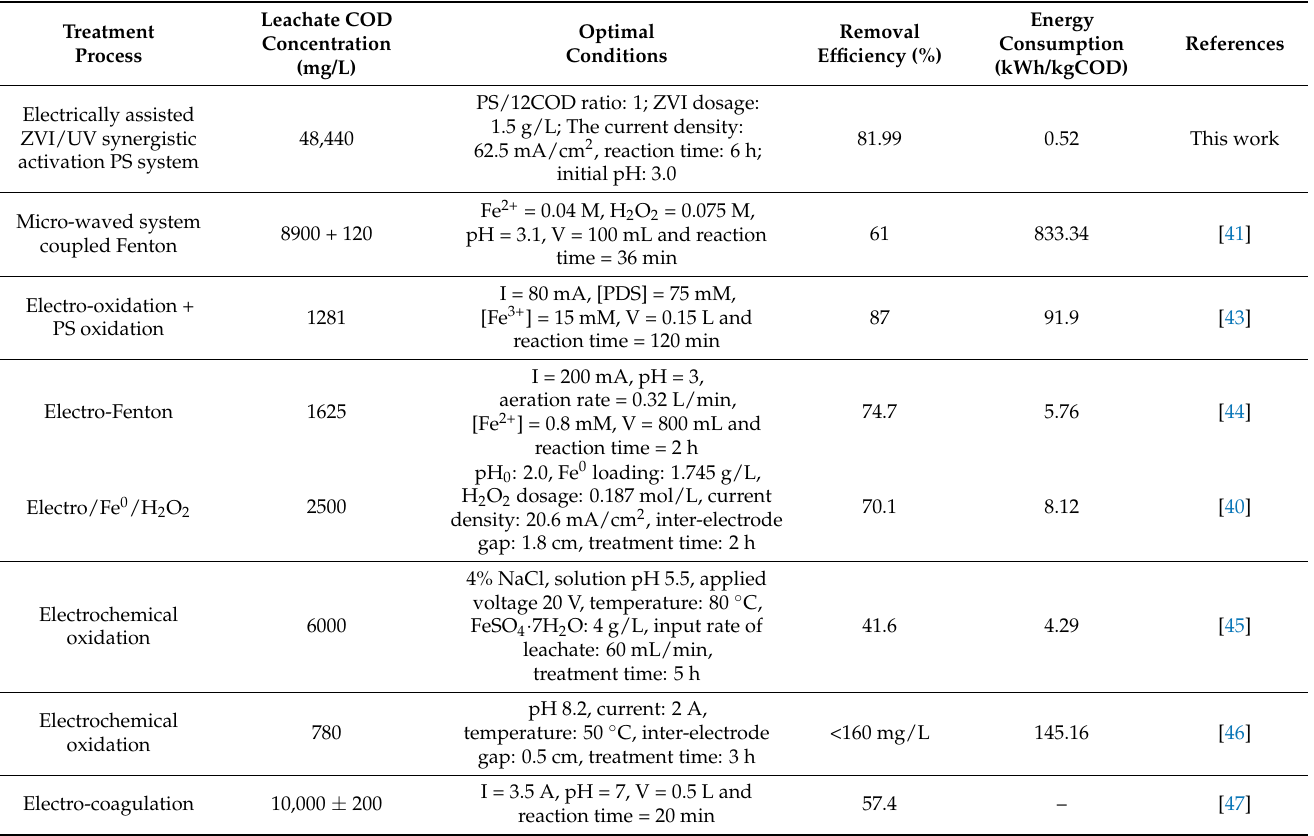
Table 1. Comparison of specific electrical energy consumption (SEEC) under the different systems for treating the